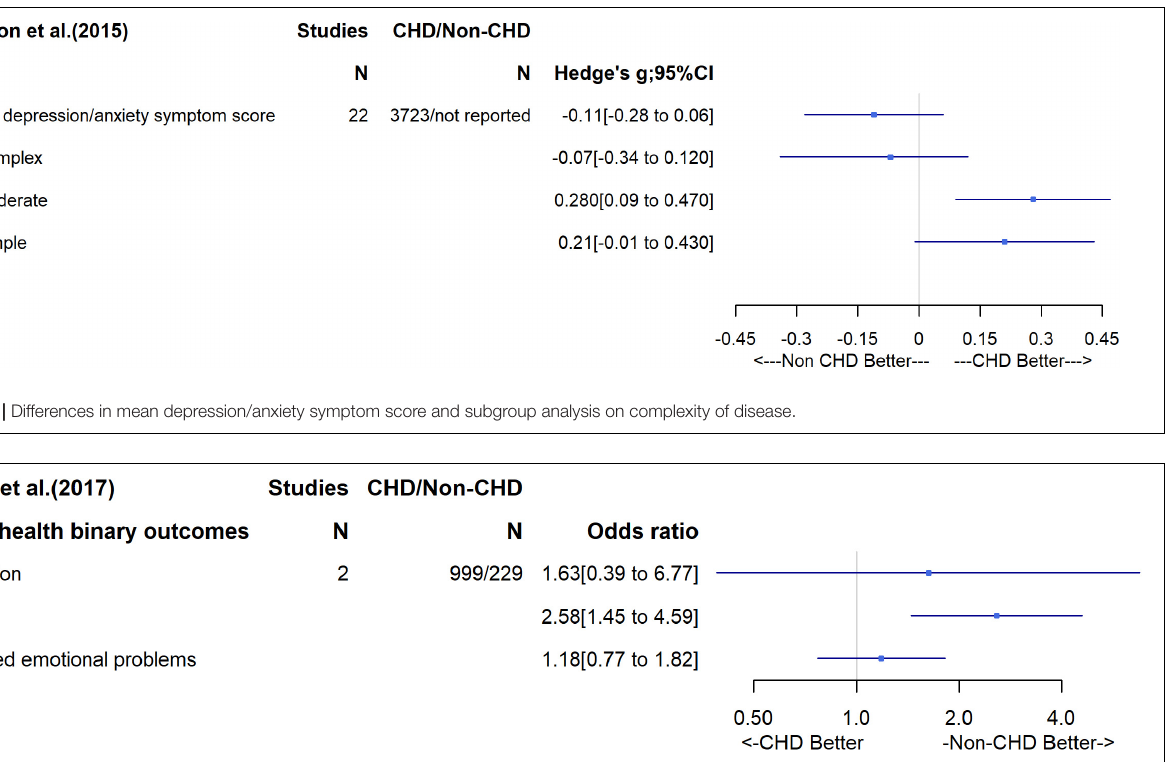
FIGURE 4 | Odds ratio for mental health binary